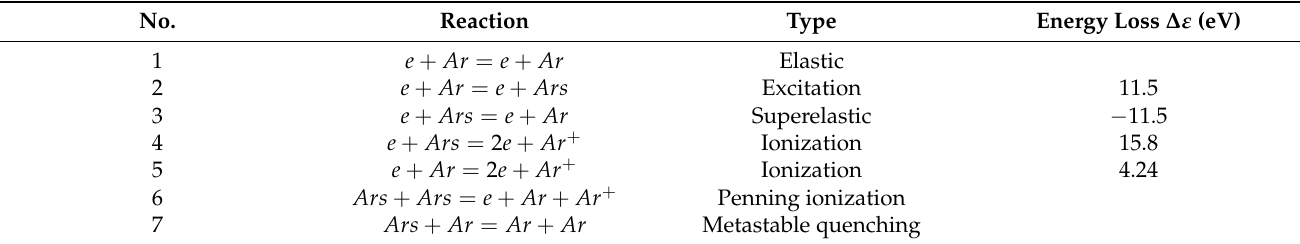
Table 1. Important collision processes in the argon